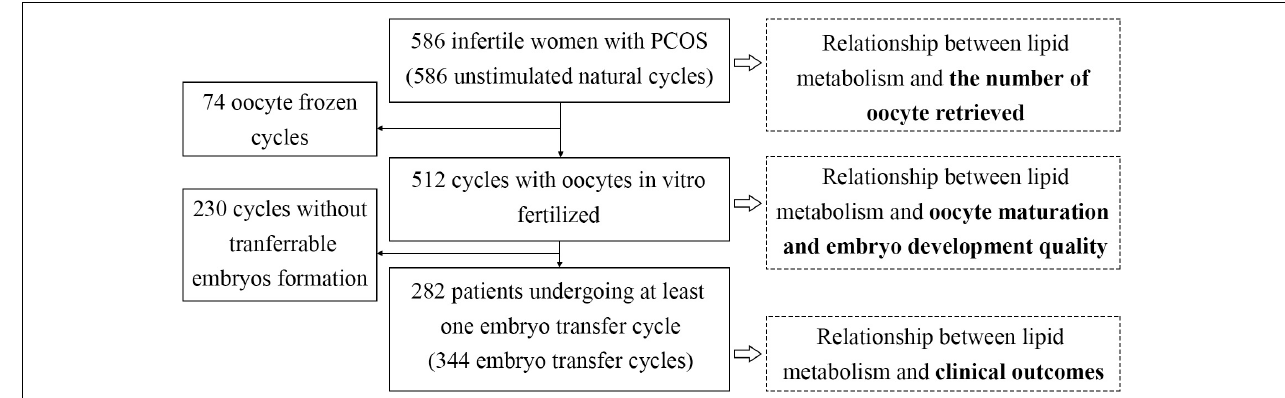
FIGURE 1 | Flowchart of the